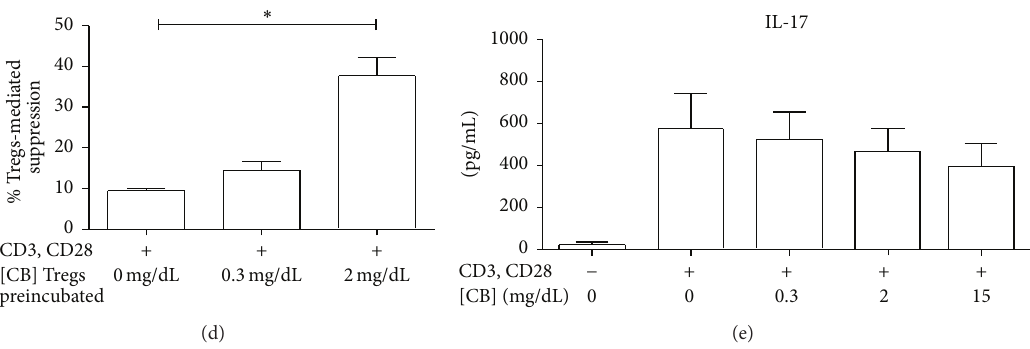
Figure 4: Treatment with CB in vitro induces an augment in the activity of Tregs. Purified CD4+CD25+FOXP3+ Tregs from pediatric healthy donors were incubated for 72 hours with and without different doses of CB. Then, Tregs were cocultured with CFSE-labeled Teff (TCD4+CD25 − ) for 7 days, and cells were stimulated with anti-CD3 and anti-CD28. (a) Dilution of fluorescence and cell count because of the proliferation of Teff stimulated with anti-CD3 and anti-CD28 cocultured with Tregs in the absence of CB. (b) Dilution fluorescence and cell count because of the proliferation of Teff when cocultured with Tregs with CB 0.3 mg/dL. (c) Dilution fluorescence and cell count because of the proliferation of Teff when cocultured with Tregs preincubated with CB 2mg/dL. Data shown are representative of three independent experiments. (d) The results are displayed as the percentage of Tregs suppression by each condition. (e) IL-17 concentration was evaluated by MAGPIXTechnologyincellsupernatantsfromCD4+TLsfrompediatrichealthydonorsstimulatedwithanti-CD3andanti-CD28inpresence or absence of CB. The medians and standard deviations of three repetitions are presented. Nonparametric Kruskal-Wallis for comparison between groups was used to calculate statistical significance. 𝑃 < 0.05 was considered statically significant. ∗ 𝑃 < 0.05 .